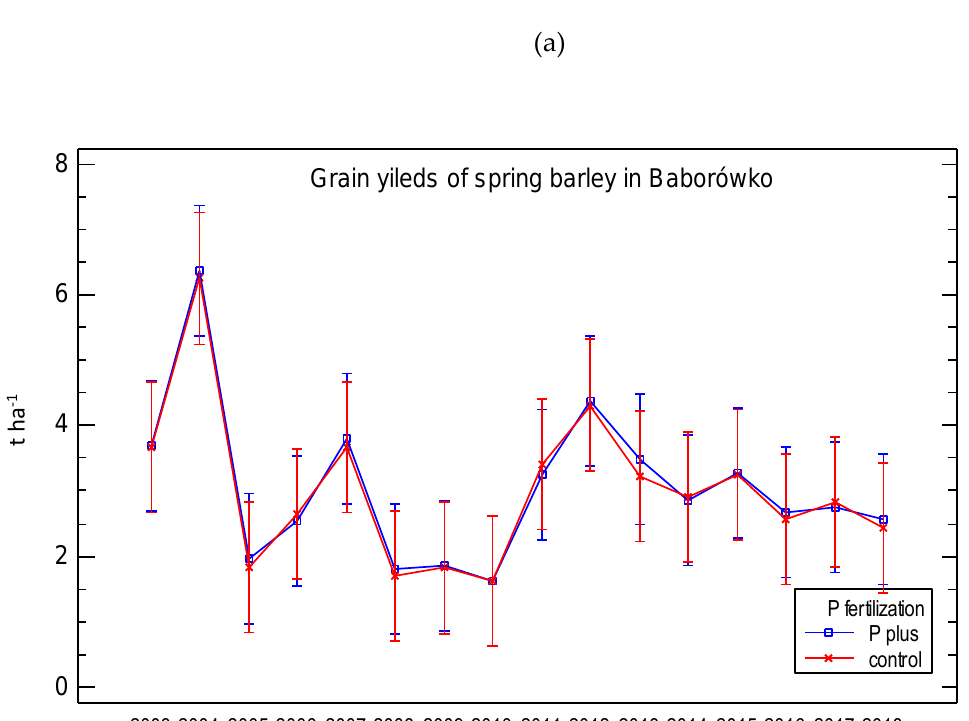
Figure 4. Grain yields of spring barley in (a) Grabów and (b) Baborówko; 95% Tukey HSD intervals; n = 384 for each location.